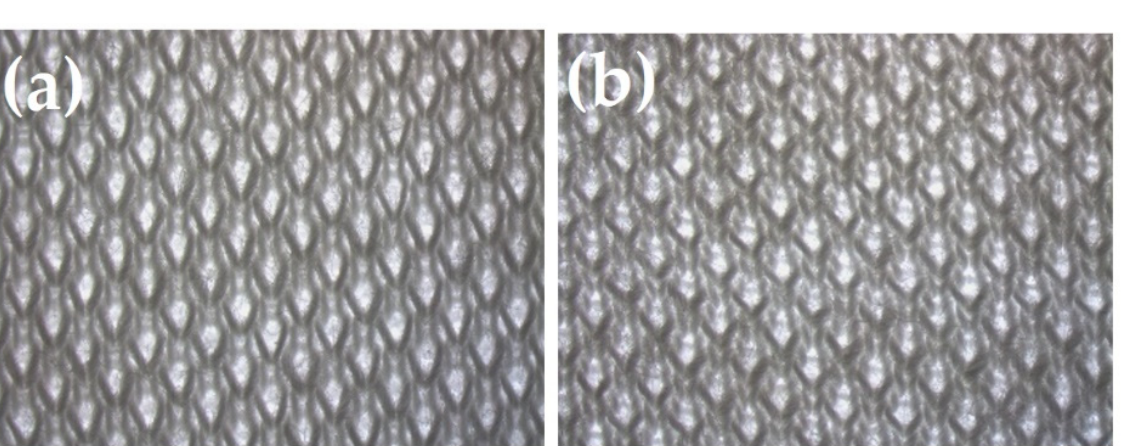
Figure 6. The right side of cotton weft-knitted fabric forming inner layer—II ( a ), left side of cotton weft-knitted fabric forming inner layer—II ( b ).